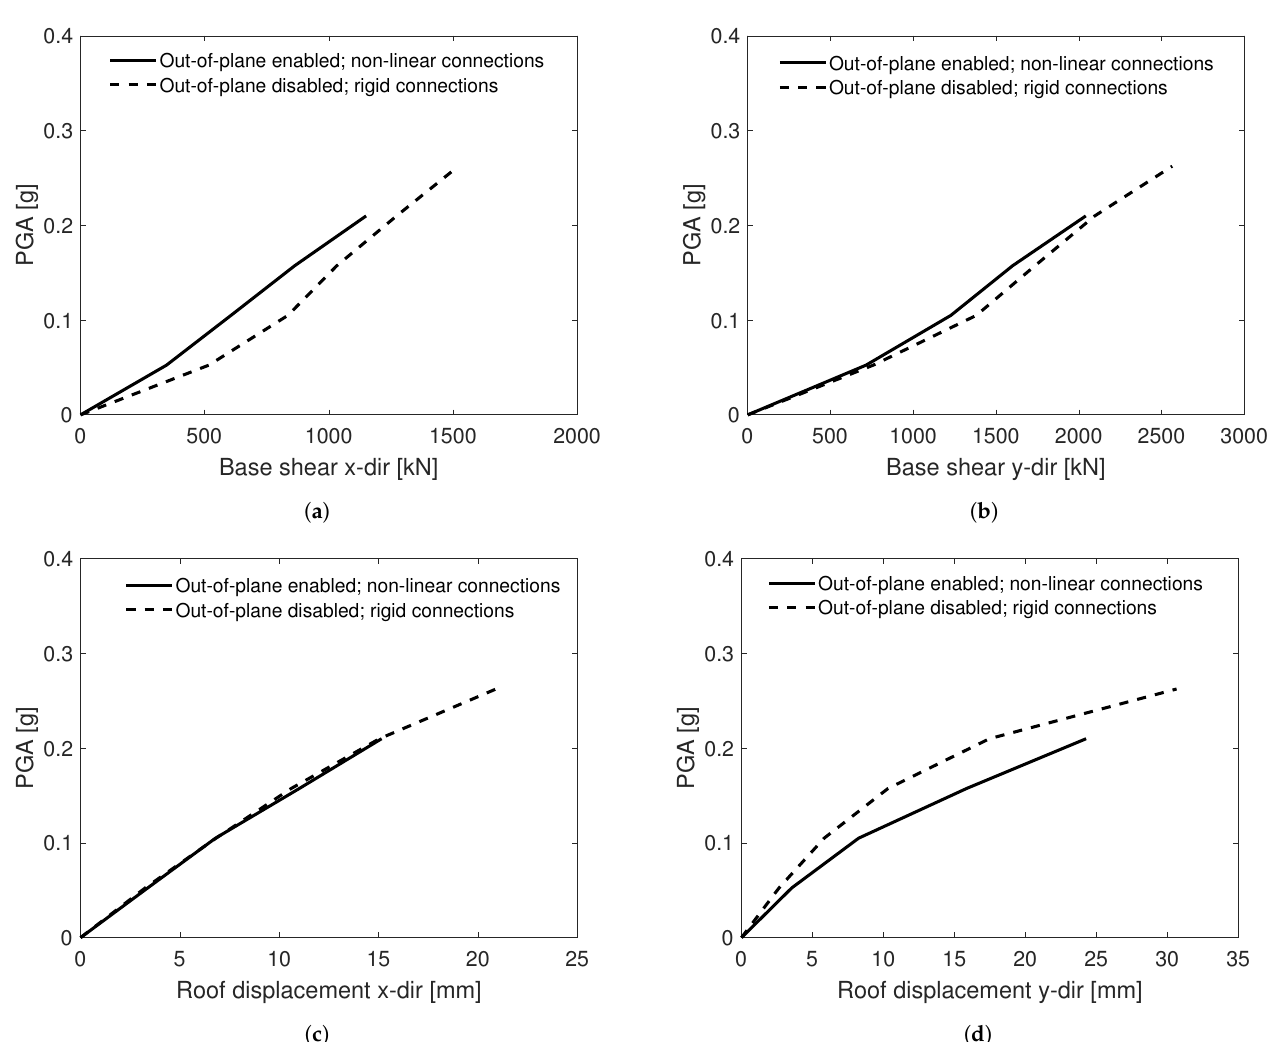
Figure 26. Lausanne Malley comparison of IDA curves models with: (i) out-of-plane enabled and non-linear connections, and (ii) out-of-plane disabled and rigid connections, displaying the maximum values of seismic demand parameters: ( a ) Total base shear in x-direction. ( b ) Total base shear in y-direction. ( c ) Average roof displacement in x-direction. ( d ) Average roof displacement in